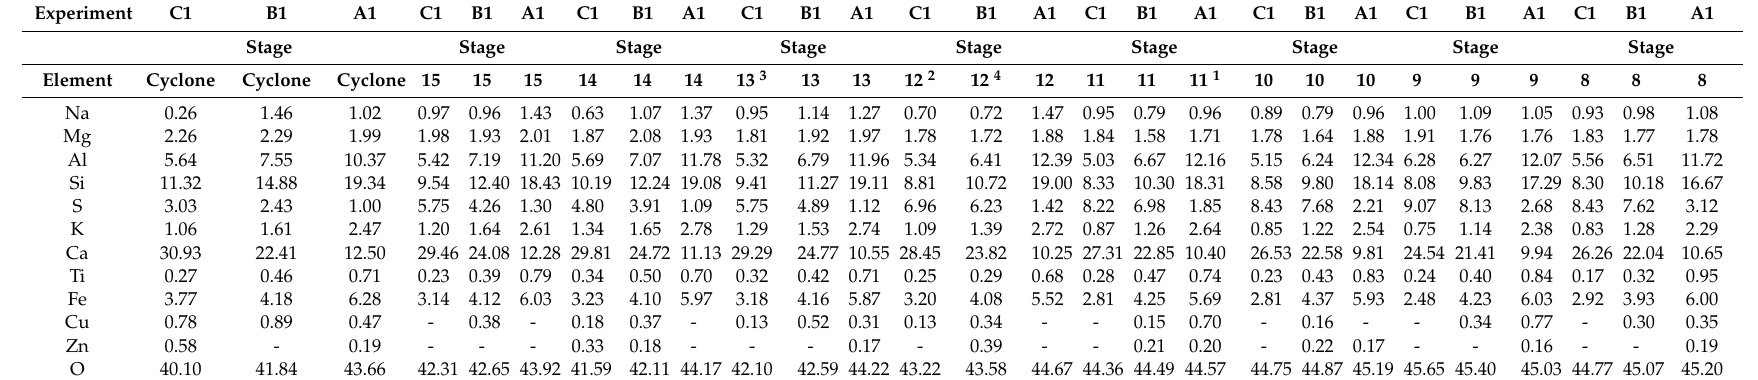
Table 7. Elemental concentration (wt% of fly ash particles) per stage and experiment for un-staged combustion